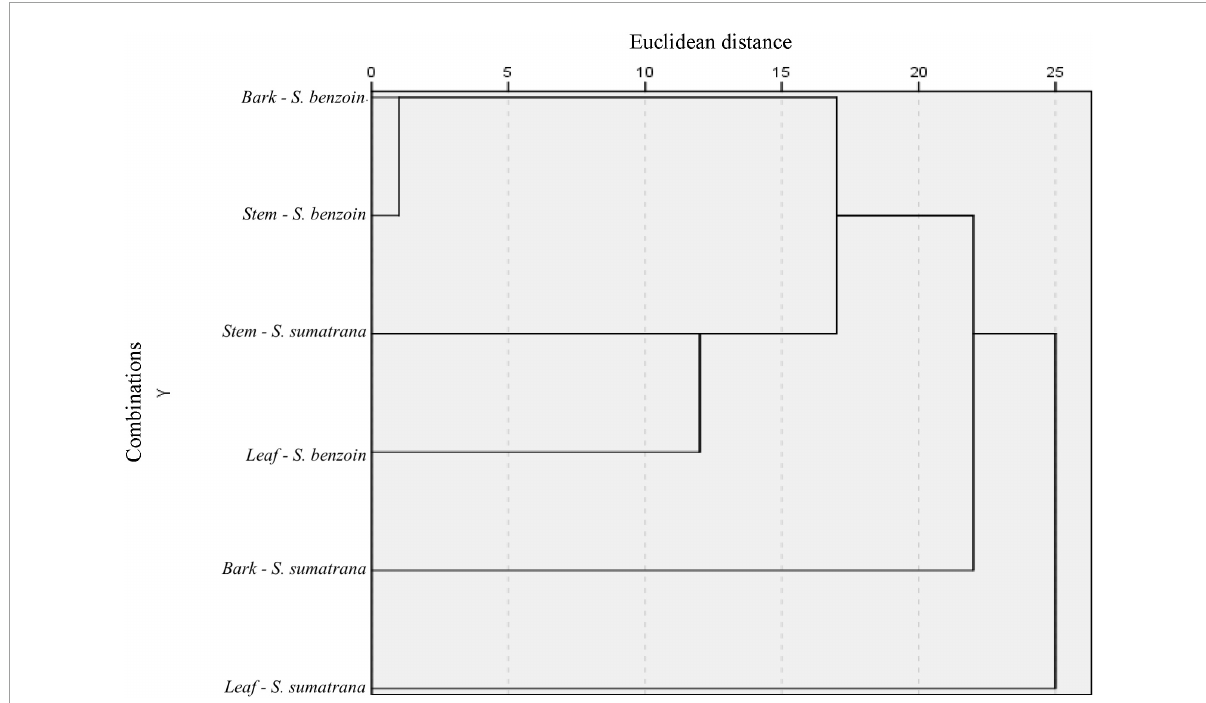
FIGURE2 Single-linkage dendrogram with combined rescaled distance clusters. Endophytic fungi species were clustered based on their origins, plant organ (bark, stem, and leaf), and host plant species ( Styrax sumatrana and Styrax benzoin ).